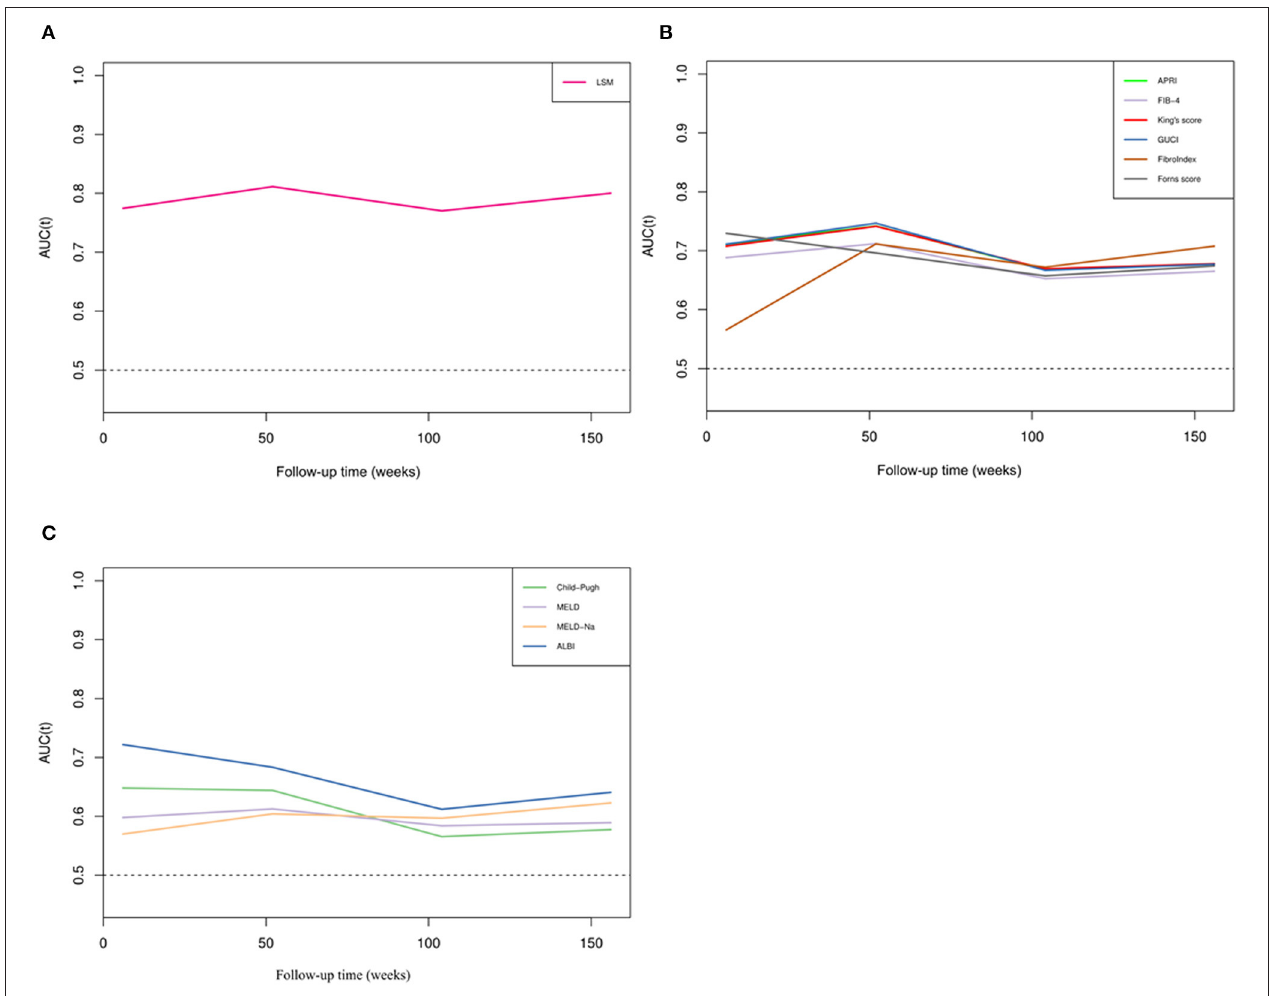
FIGURE 3 | Time-dependent ROC curves of different parameters. (A) Time-dependent ROC curve of LSM. (B) Time-dependent ROC curves of non-invasive fibrosis scores. (C) Time-dependent ROC curves of liver function scores.